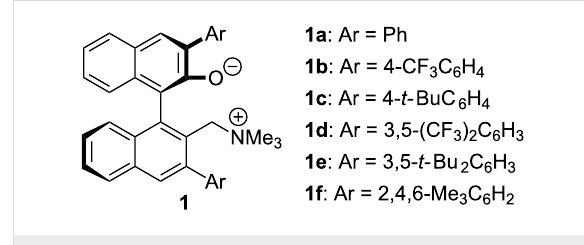
Figure 1: Chiral ammonium